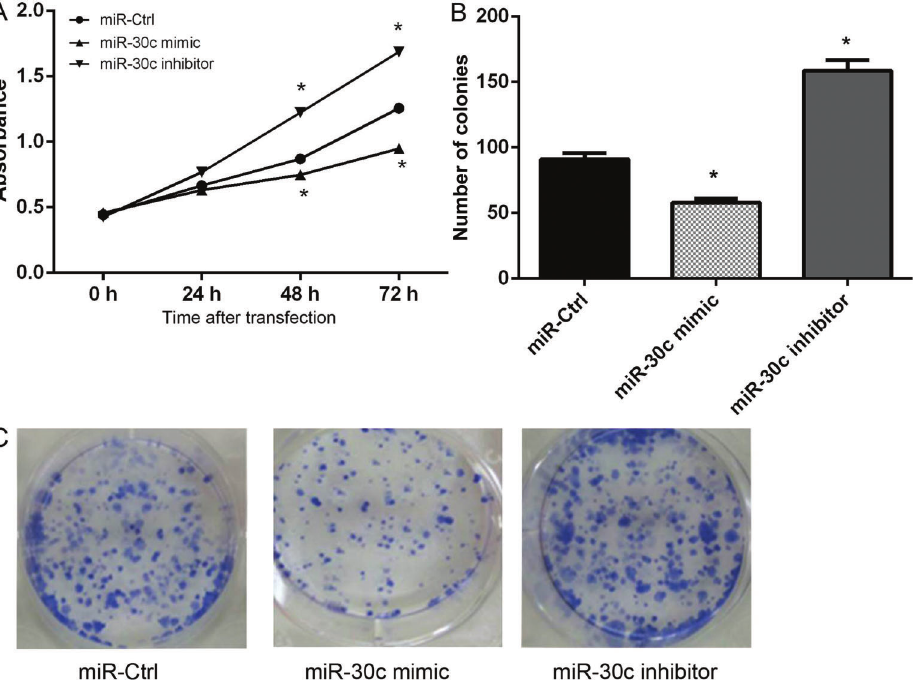
Figure 3. Overexpression of miR-30c inhibits cell proliferation in hepatoma cells. A , MTTassay shows the cell viability of hepatoma cells after transfection with miR-30c mimic, inhibitor or scramble control. B - C , Colony formation assay shows the number of colonies after hepatoma cells were transfected with miR-30c mimic, inhibitor or scramble